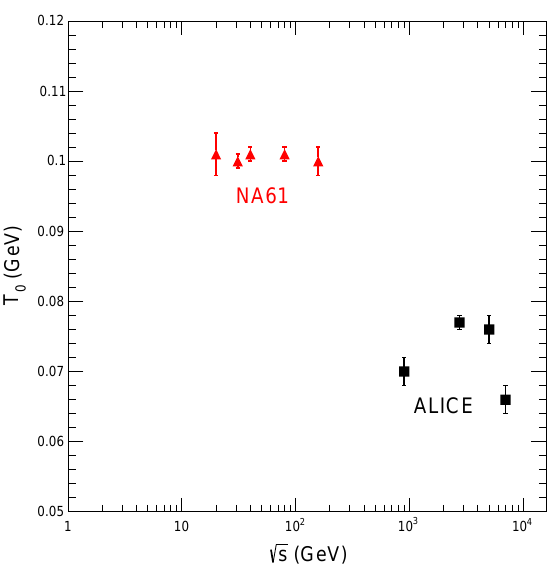
Figure 2. The energy dependence of the temperature parameter T 0 . The triangular points are values of T 0 extracted from data in pp collisions obtained by the NA61/SHINE [14] Collaboration for pions (see Table 4). The squares are the T 0 values in Table 1. All points were obtained by fits using Equation (6).